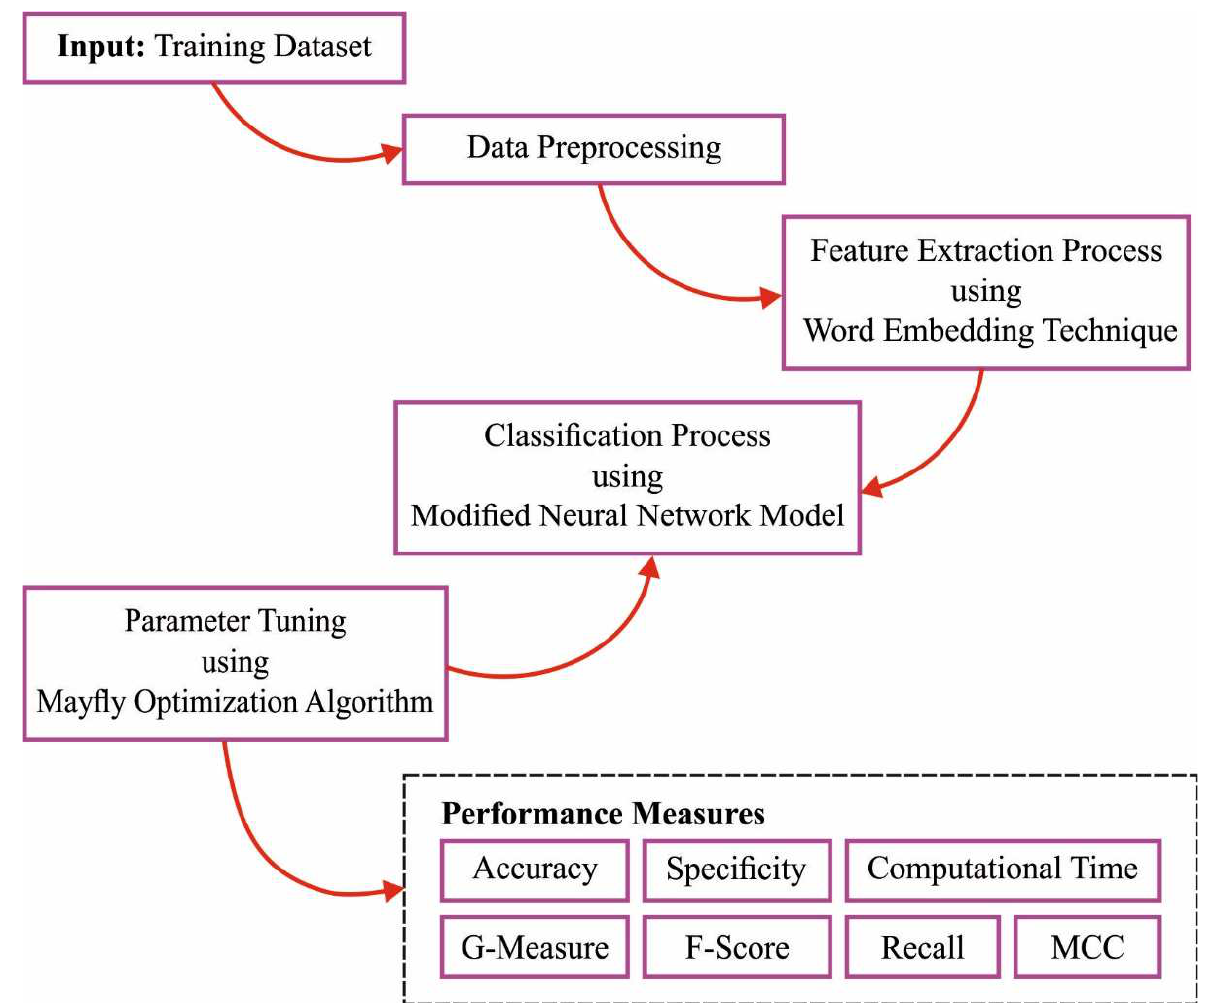
Figure 1. Overall block diagram of the CL-DLBIDC approach.